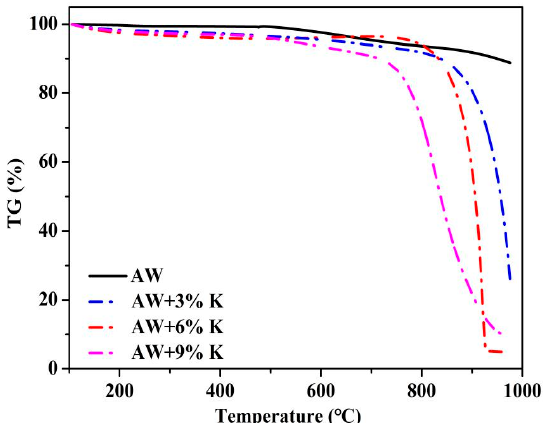
Figure 1. Effects of KCl concentration on char gasification (temperature programmed from room temperature to the specified temperature at an average speed) .